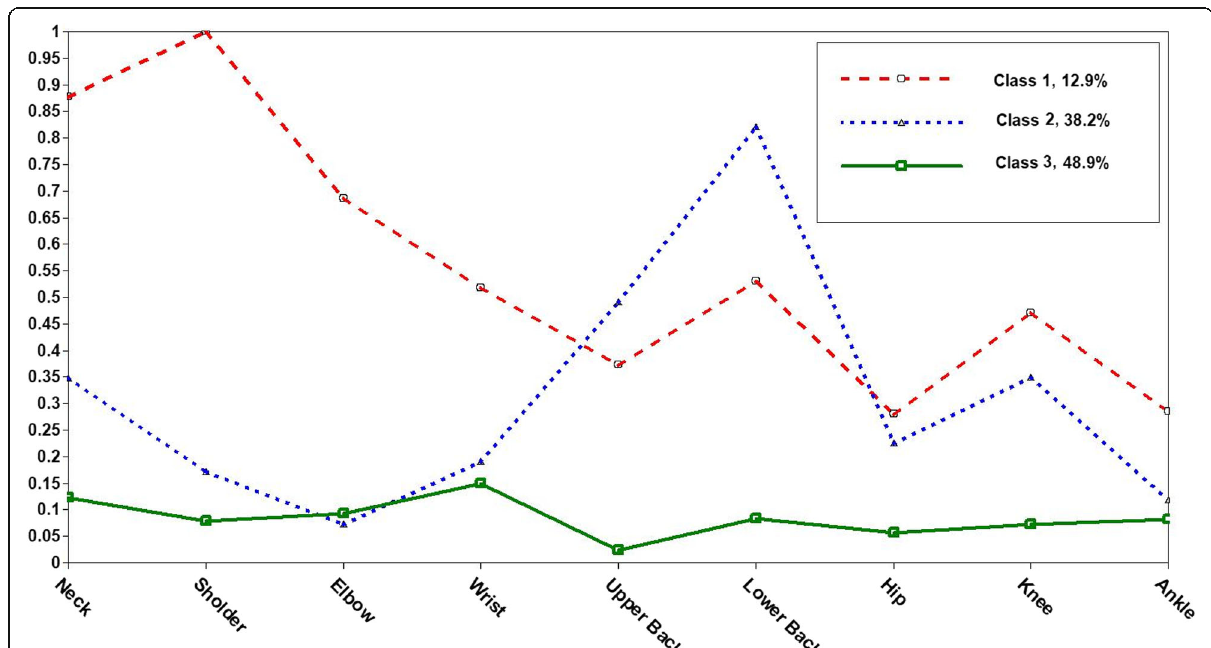
Fig. 1 Self-reported frequency of MSDs stratified by latent class-derived